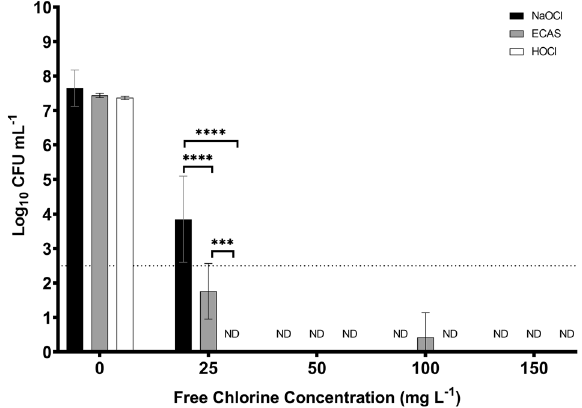
Fig. 1 Antimicrobial ef fi cacy of NaOCl, ECAS and HOCl against planktonic Escherichia coli with no inhibitory solution. Antimicro- bial ef fi cacy of NaOCl [black], ECAS [grey] and HOCl [white] using standardised free chlorine concentrations against E. coli ATCC 10536, and assessed using BS EN 1040 ( 41 British Standards Institution, 2005a). Dotted line represents the minimum log reduction (5 log CFU mL − 1 ) required to demonstrate basic bactericidal activity under the experimental conditions of the assay ( n = 3 ± standard deviation [s.d.]). Signi fi cant differences ( p -values) calculated through a two- way ANOVA with Tukey ’ s comparison post-test, with a con fi dence interval of 95% (**** p < 0.0001; *** p < 0.001). ND = not detected. Error bars represent standard deviation. Table 1. CT values (mg min L − 1 ) for 5-log reduction of planktonic E. coli in the absence (Sterile DI) and presence (Clean and dirty BSA) of inhibitory solutions and a 2-log reduction of P. aeruginosa bio fi lm.